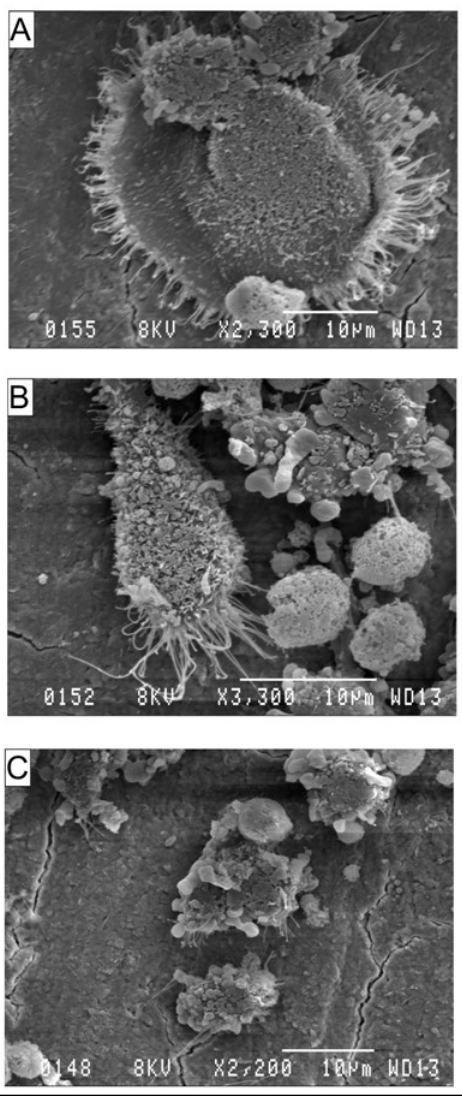
Figure 3. Effects of AA and DHA on osteoclast ultrastructure. Scanning electron micrographs (SEM) of RAW264.7 cells grown on bovine cortical bone slices. RAW264.7 cells were differentiated in the presence of 30 ng·mL −1 RANKL or PUFAs at 20 μg·mL